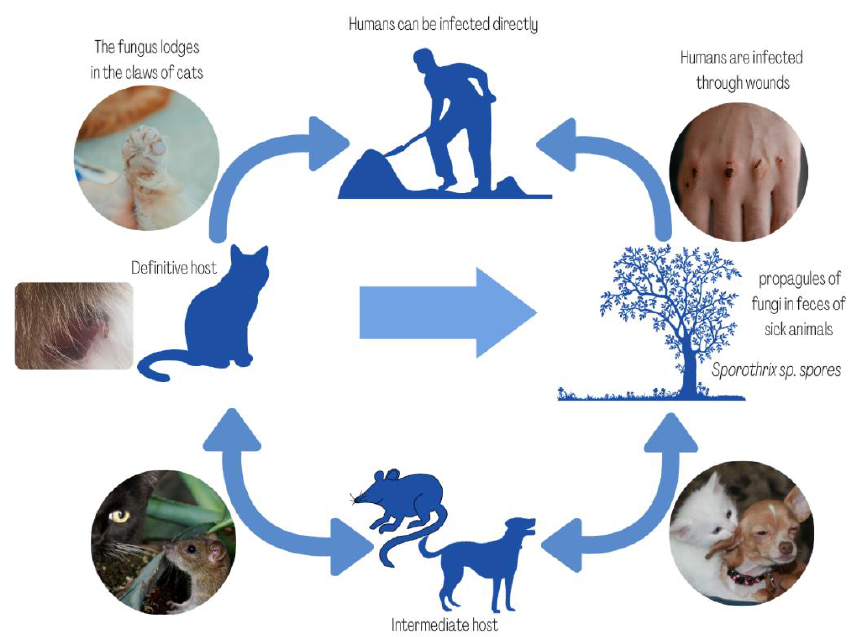
Figure 2. Evolutionary cycle of Sporothrix spp. infection.